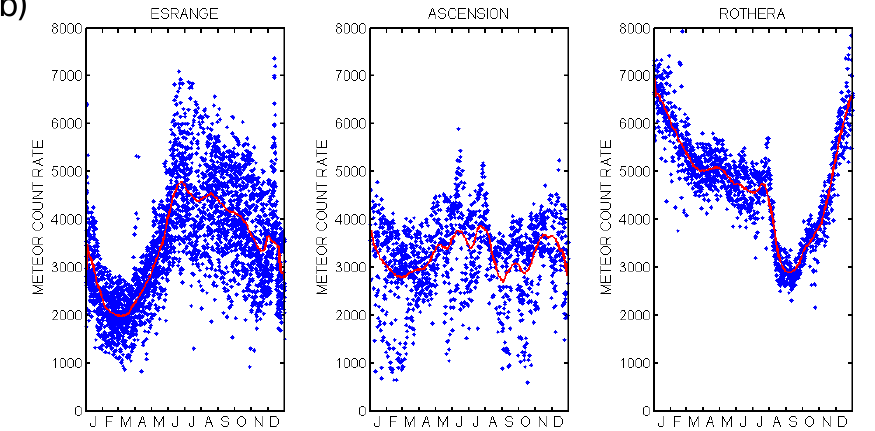
Fig. 2. (a) Daily meteor count rate (blue dots) at Esrange (1999–2008), Ascension Island (2001–2007), and Rothera (2005–2008). The red line is the 30-day running mean. (b) Composite daily meteor count rate (blue dots) versus calendar date. Red line is the 30-day running